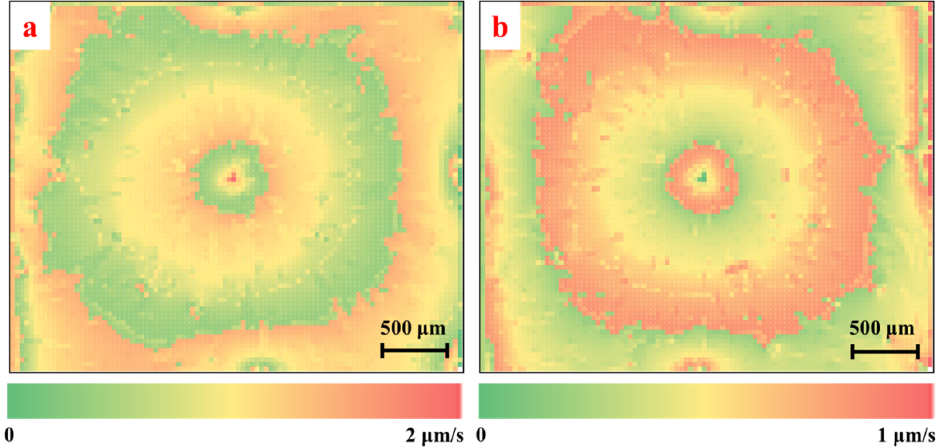
Figure 6. Flow speed distribution of Samples ( a , b ) at the final time (1000 min).